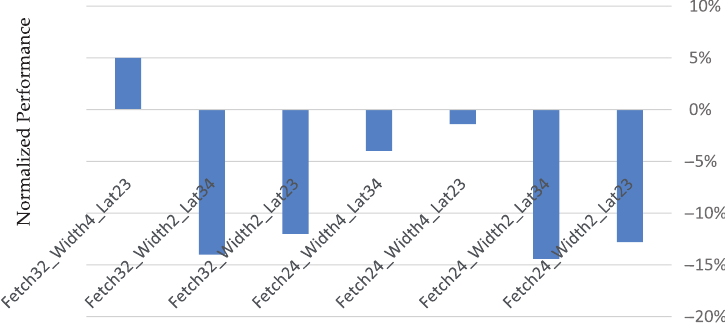
Figure 8. Pipeline exploration with different parameters for CFP